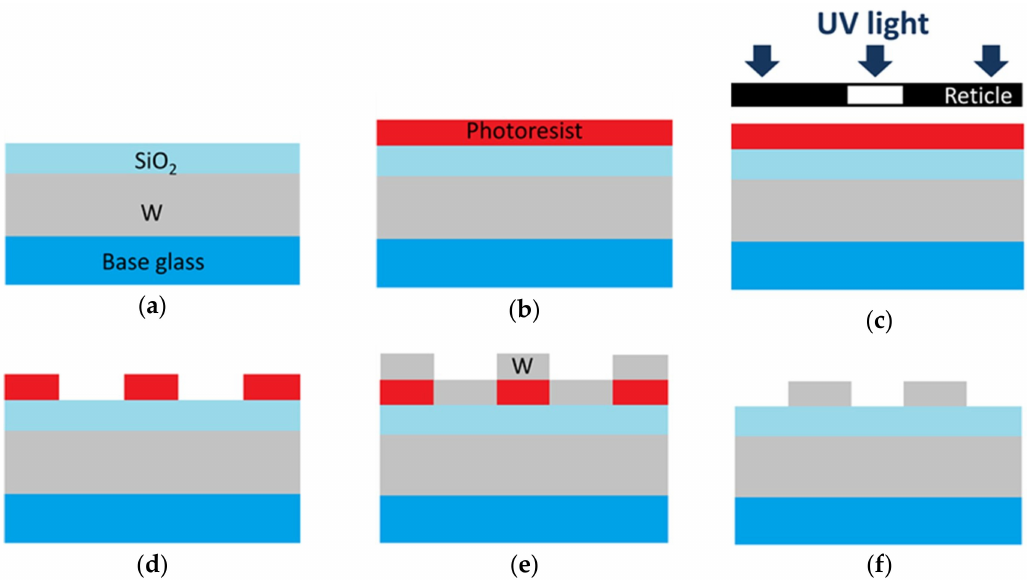
Figure 2. Schematic of the fabrication process of the proposed metasurface. ( a ) Thin W and SiO 2 films were sputtered; ( b ) photoresist coating; ( c ) ultraviolet (UV) light exposure through a reticle; ( d ) the photoresist layer was developed to form a resist pattern; ( e ) the thin W layer was sputtered; ( f ) lift-off (photoresist with the unnecessary W removed). Reproduced with permission from [8], published by OSA Publishing,